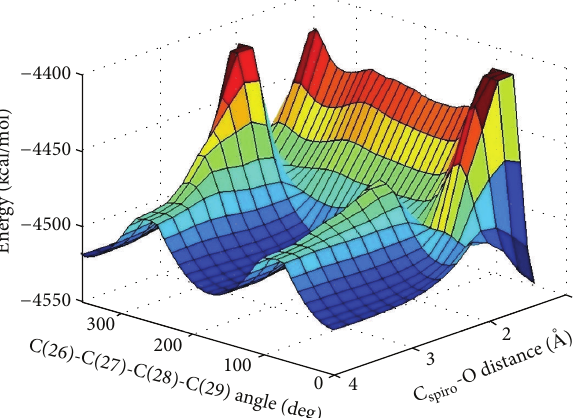
Figure 9: The same result is presented as in Figure 8 but in the form of geodesic lines and, in addition, the energy scale is limited by the interval of 50